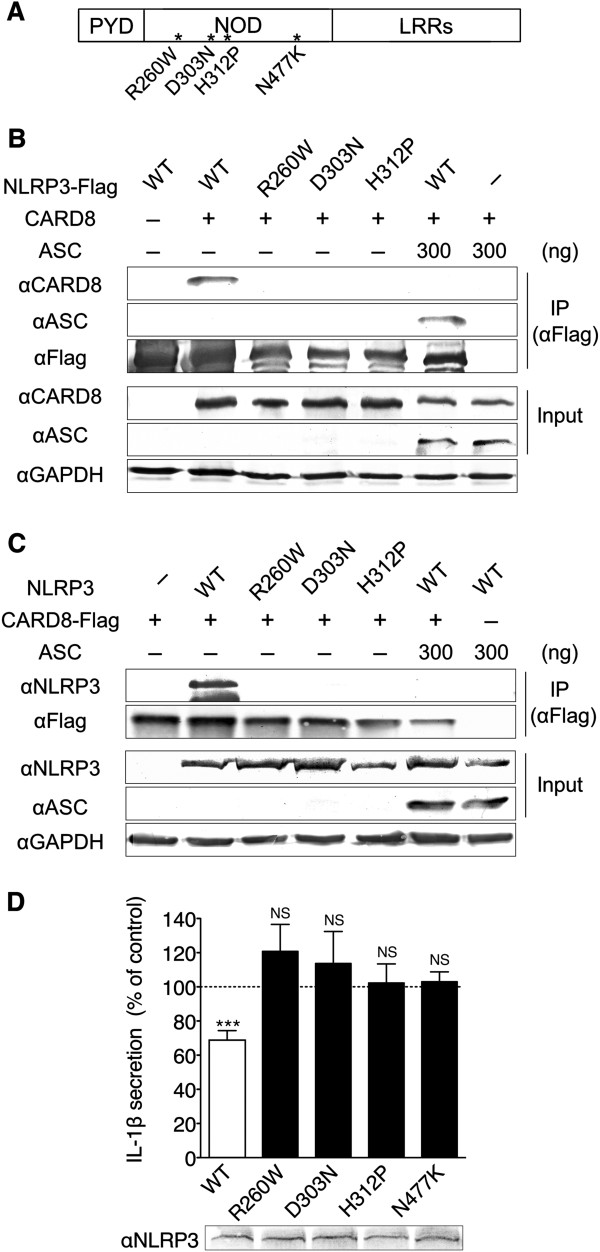
CARD8 fails to bind CAPS-associated NLRP3 mutants. (A) Diagrammatic representation of the three-domain structure of NLRP3 with asterisks indicating the location of mutations. (B) Human Embryonic Kidney (HEK)293 cells were transfected with expression plasmids (500 ng each) for NLRP3-Flag (wild type (WT), R260W, D303N or H312P) and caspase recruitment domain-containing protein 8 (CARD8) with or without apoptosis-associated speck-like protein containing a CARD (ASC) (300 ng). At 24 hours after transfection, expression of each protein (Input) was confirmed by Western blotting. Simultaneously, the whole cell lysates were the immunoprecipitated (IP) with anti-Flag antibody and analyzed by Western blotting. (C) Similar experiments as above were carried out, but CARD8 was Flag-tagged in place of NLRP3. (D) HEK293 cells were transfected with expression plasmids of proIL-1β (200 ng), NLRP3 (WT, R260W, D303N, H312P or N477K) (50 ng), procaspase-1 (10 ng), ASC (25 ng) and CARD8 or an empty vector (100 ng). At 24 hours after transfection, the supernatants were replaced by fresh medium and incubated for another 24 hours; thereafter, the second supernatants were subjected to ELISA and pellets were analyzed by Western blotting. Levels of IL-1β secretion from transfectants were expressed as a relative percentage compared with those from cells with each NLRP3 without CARD8. Each column represents the mean ± SD (n = 3), ***P <0.001 vs. no CARD8. NS, not significant vs. no CARD8.